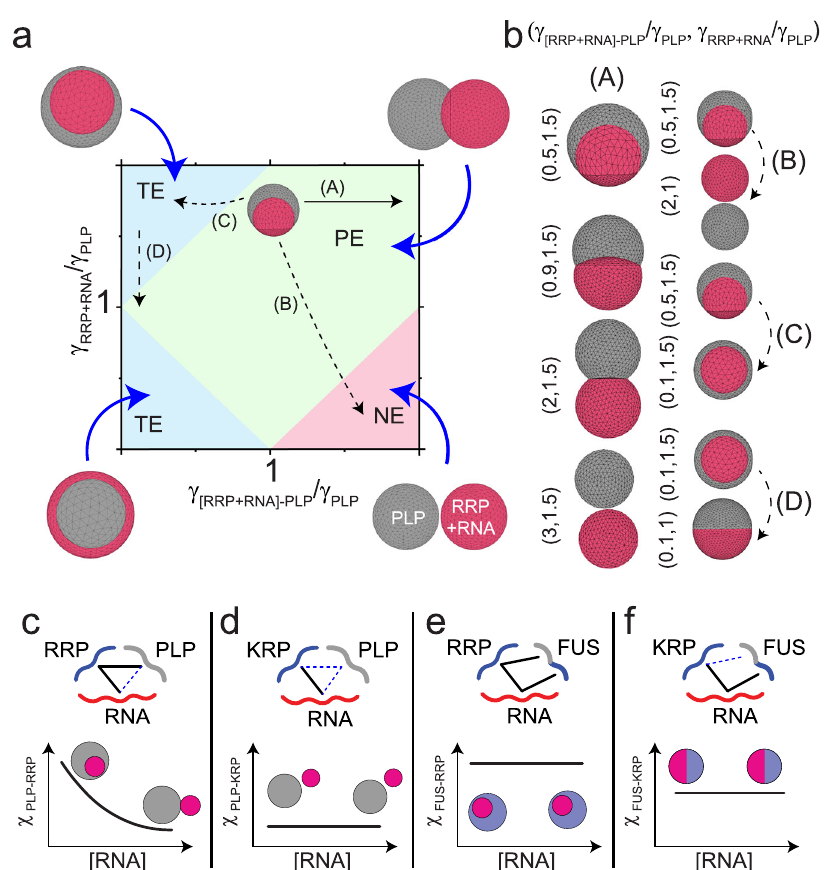
Fig. 6 The stability diagram of a pair of coexisting condensates provides a link between intermolecular interactions and multiphasic morphology. a Stability diagram for PLP droplets coexistence pattern with RRP-RNA droplets from fl uid-interface modeling simulations. In these simulations, γ fi xed and γ and γ ½ were varied. The shaded regions mark the different morphological states: total engulfment (TE), partial engulfment RRP þ RNA RRP þ RNA (cid:2)(cid:3) PLP (PE), and non-engulfment (NE). The solid black arrow indicates a continuous morphological transition with RNA dosage as described in the text. The dashed lines correspond to discrete transitions due to sequence variations. b Simulation strips showing the continuous and discrete morphological transitions as the values of the interfacial tensions are varied along with the corresponding arrows in the stability diagram in ( a ). c – f Schematic diagrams showing the interactions between the ternary components as well as the observed morphology as a function of RNA concentration. The schematic plots show how the interactions between the two types of droplets ( χ ) are expected to change as a function of RNA dosage. The solid lines in the schematic interaction diagrams indicate strong interactions while the dashed lines indicate weak and/or absent